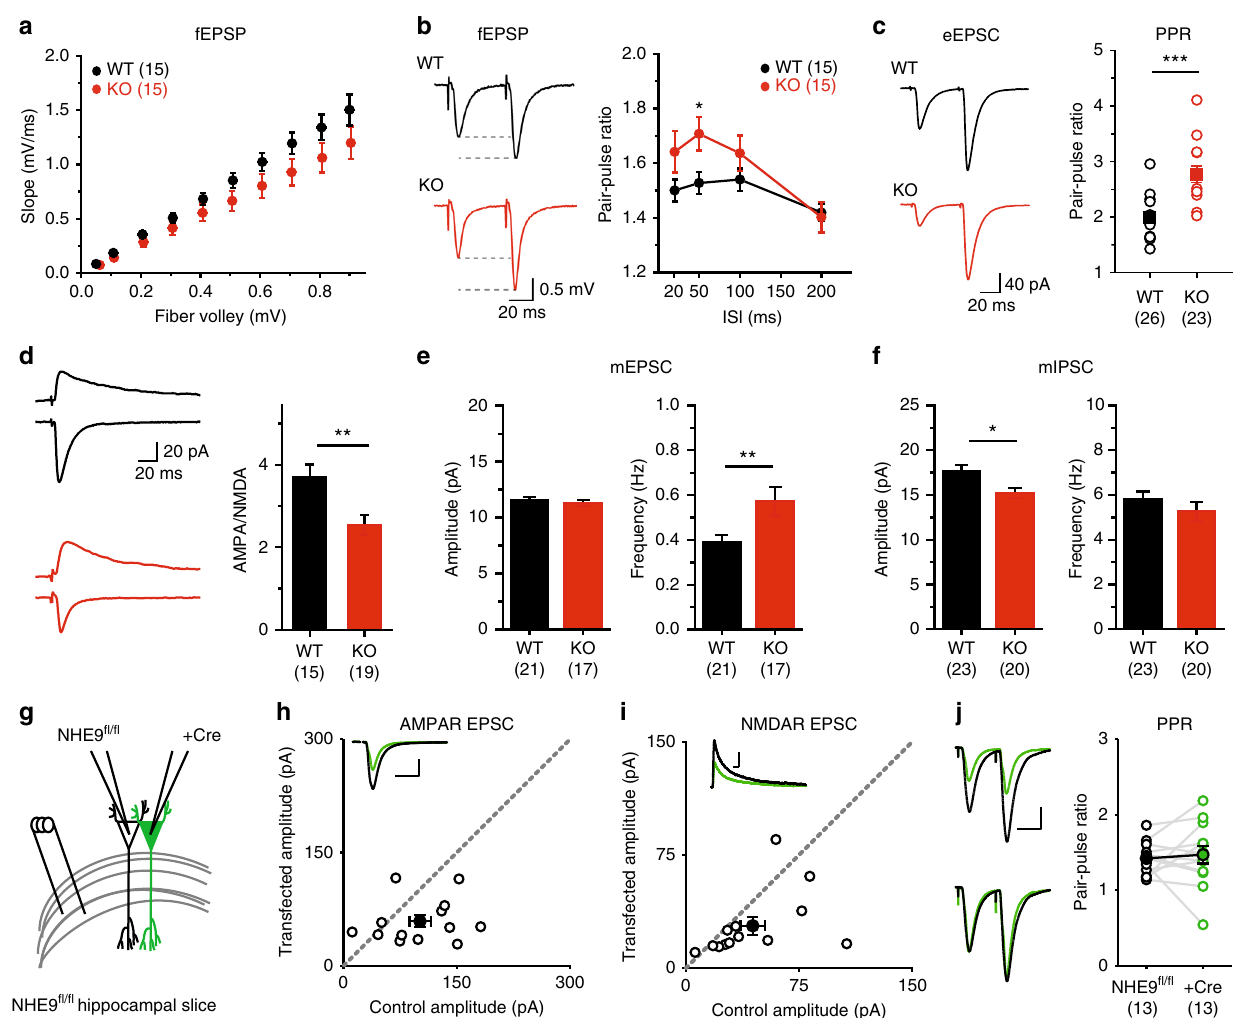
Fig. 4 Loss of NHE9 has pleiotropic effects on hippocampal synaptic transmission. a fEPSPs recorded in CA1 stratum radiatum are reduced in acute hippocampal slices from NHE9 KO mice. Symbols indicate mean ± s.e.m. p = 0.0002 for the difference between genotypes by two-way ANOVA. WT, n = 15 neurons/3 mice; KO, n = 15 neurons/3 mice. b The paired-pulse ratio of fEPSP response at multiple interstimulus intervals (ISIs) shows a signi fi cant increase in NHE9 KO slices. Representative traces are shown on the left and mean ± s.e.m. are plotted in the graph at the right. * p < 0.05 by unpaired two- tailed Student ’ s t test. WT, n = 15 neurons/3 mice; KO, n = 15 neurons/3 mice. c Whole cell recording of evoked EPSCs from pyramidal neurons in CA1 also shows increased PPR at 50 ms ISI in NHE9 KO slices. **** p < 0.0001 by unpaired two-tailed Student ’ s t test. WT, n = 26 neurons/4 mice; KO, n = 23 neurons/4 mice. d AMPA/NMDA ratios from WT ( n = 15 neurons/3 animals) and KO ( n = 19 neurons/4 animals) are compared. ** p < 0.01. e Whole cell recordings from CA1 neurons of NHE9 KO mice show normal mEPSC amplitude but increased frequency. ** p = 0.0098, F-test p = 0.01 by unpaired two- tailed Student ’ s t test. WT, n = 21 neurons/4 mice; KO, n = 17 neurons/4 mice. f mIPSC amplitude is reduced and the frequency unchanged in NHE9 KO neurons. p = 0.011 by unpaired two-tailed Student ’ s t test. WT, n = 23 neurons/4 mice; KO, n = 20 neurons/4 mice. g Schematic of single cell KO recording of NHE9 in cKO slices. h , i NHE9 deletion caused equivalent reductions in AMPAR and NMDAR transmission as compared to the simultaneously recorded control neuron. WT, n = 13 neurons/3 mice; KO, n = 13 neurons/3 mice; * p < 0.05 by paired Student ’ s t test. j No change in paired-pulse ratio was detected in the postsynaptic KO neuron, WT, n = 13 neurons/3 mice; KO, n = 13 neurons/3